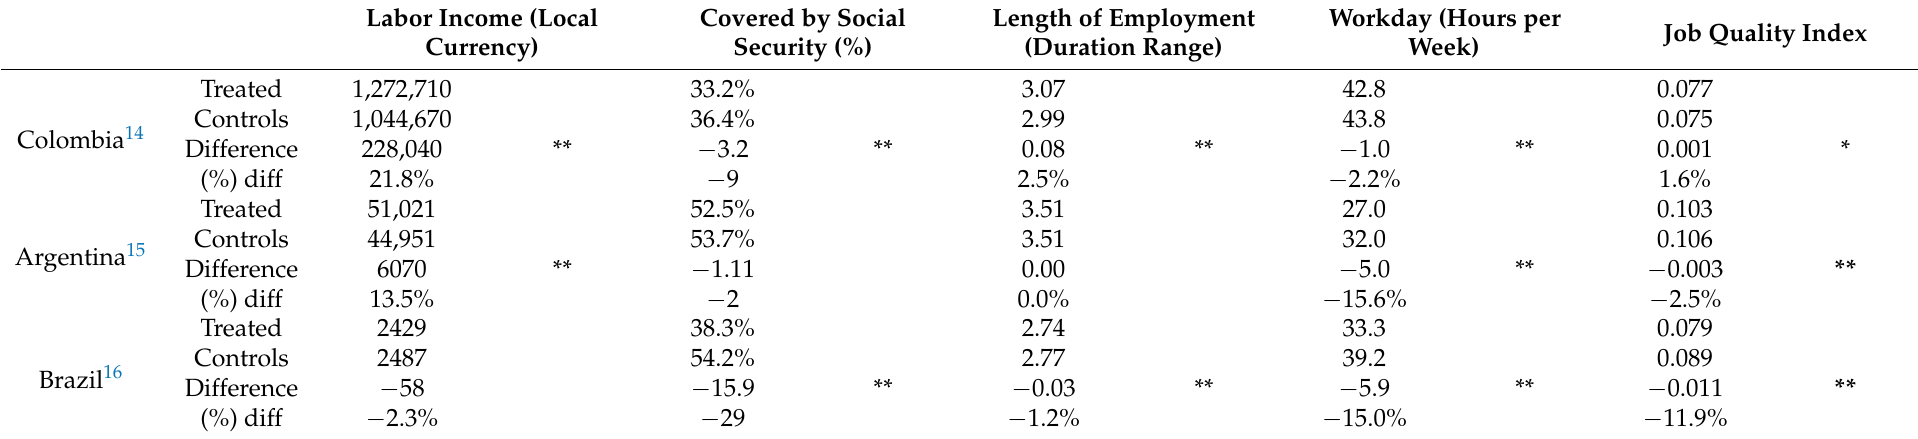
Table 3. Differences between teleworkers and other workers in the job quality index and its components by